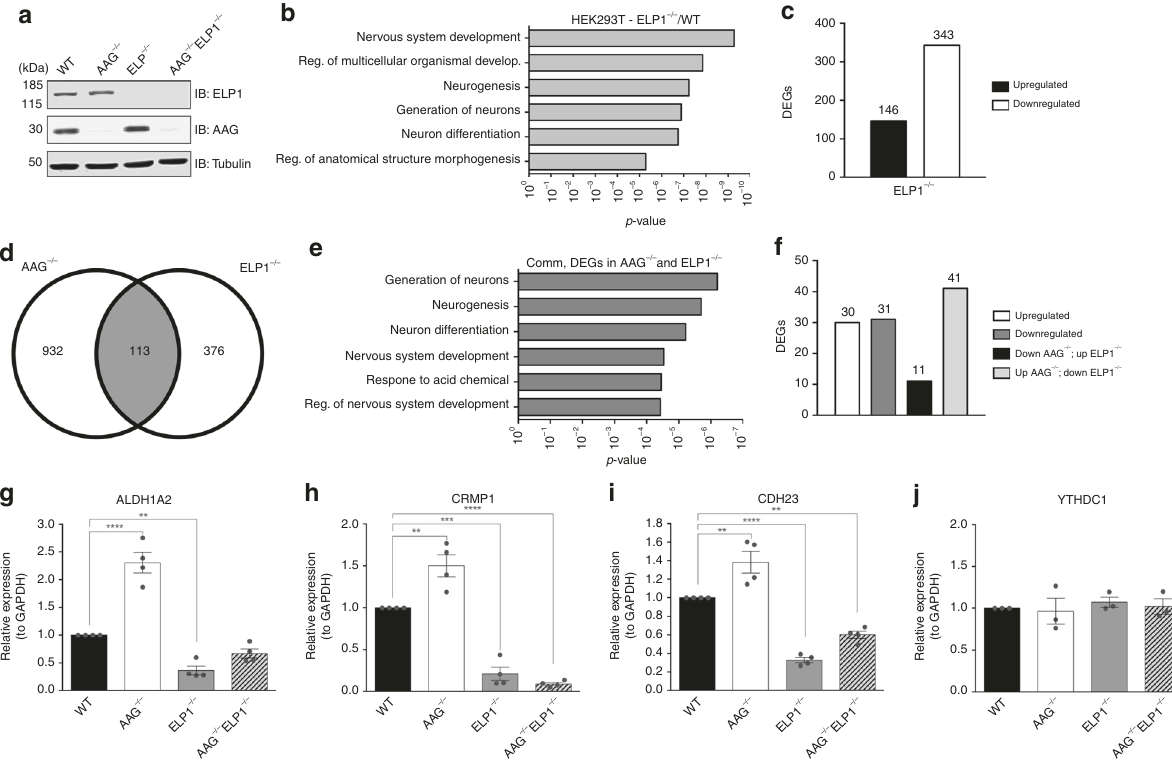
Fig. 3 Elongator and AAG co-regulate gene expression. a Immunoblot of HEK293T whole-cell extracts (WCEs) from WT, AAG − / − , ELP1 − / − , and AAG − / − ELP1 − / − cell lines generated via CRISPR-Cas9 technology. b Top six biological processes (BP) gene ontology (GO) terms as determined by DAVID for genes dysregulated in HEK293T ELP1 − / − cells when compared to WT cells. c Downregulated and upregulated differentially expressed genes (DEGs) in HEK293T ELP1 − / − cells. d Venn diagrams of AAG- and ELP1-regulated genes in HEK293T cells. e Top six BP GO terms as determined by DAVID of genes co-regulated by AAG and ELP1 in HEK293T cells. f Directionality of DEGs regulated by AAG and ELP1 in HEK293T cells. g – j Relative mRNA levels of ALDH1A2 ( g ), CRMP1 ( h ), CDH23 ( i ) and YTHDC1 (negative control) ( j ) genes in HEK293T WT, AAG − / − , ELP1 − / − and AAG − / − ELP1 − / − cells. Error bars represent mean ± SEM ( n ≥ 3). ** p ≤ 0.01; *** p ≤ 0.001; **** p ≤ 0.0001, one-way ANOVA. Source data are provided as Source Data fi